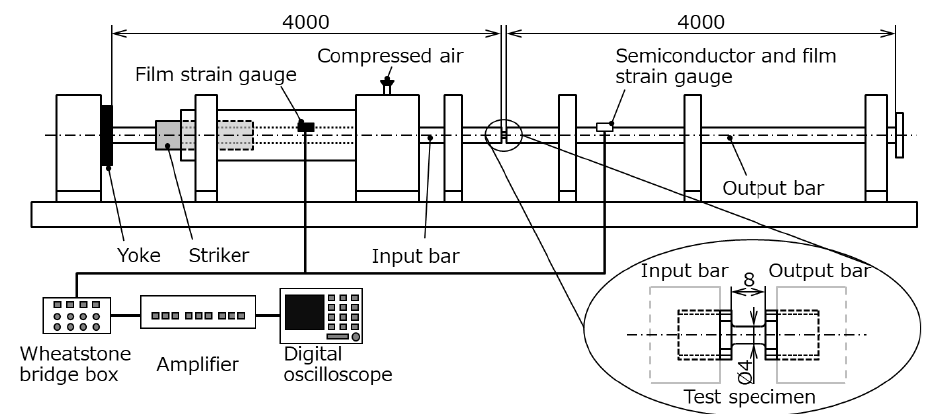
Fig. 2. Schematic of split Hopkinson bar tensile test apparatus (unit: